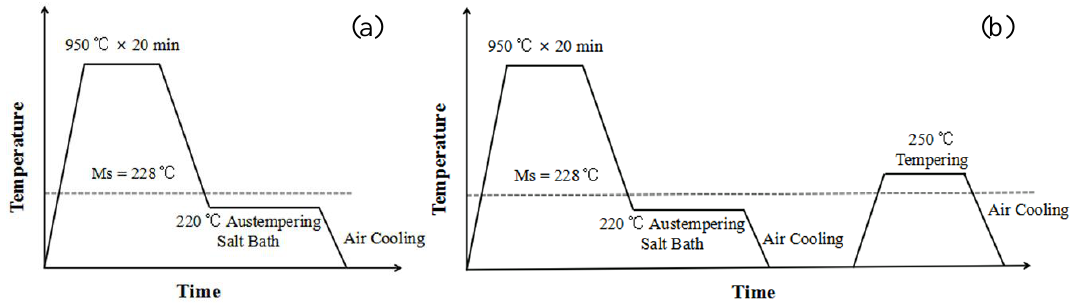
Figure 2. Heat treatment processes of low-temperature bainite transformation in the experiment. ( a ) isothermal below Ms ( b ) isothermal and tempering.